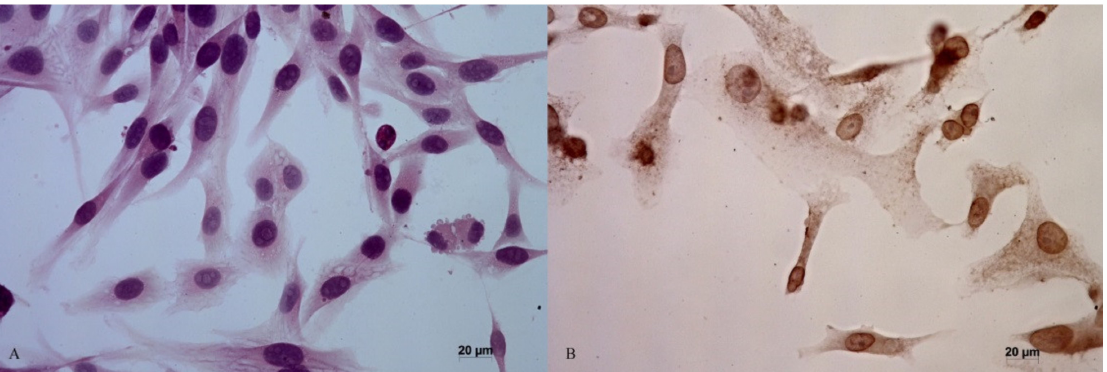
Figure 1. Non-apoptotic ( A ) and apoptotic ( B ) D-17 cell cultures observed in optical microscopy, 40 × . B-brown pigment marks apoptotic